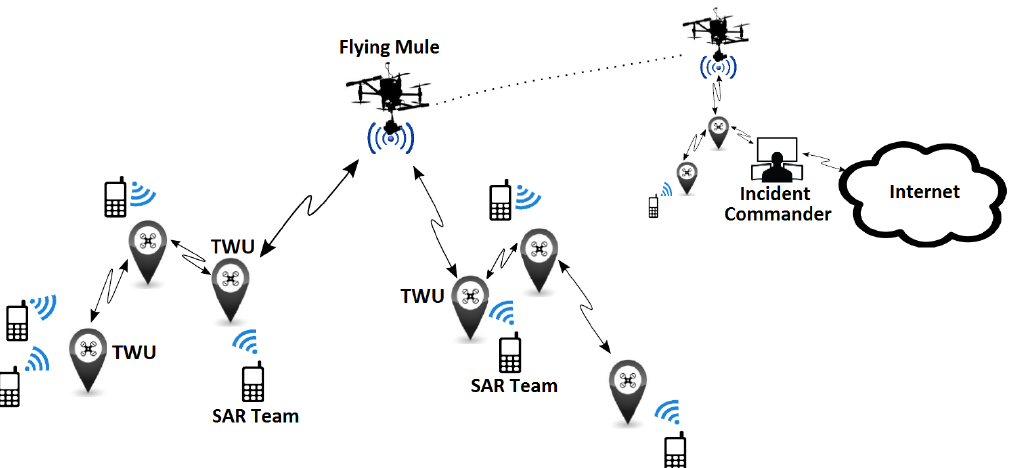
Figure 1. Example of an FRTN that includes eight team-centered witness units (TWUs) and two flying mules. Members of search-and-rescue (SAR) teams are depicted by smartphones, the “location” symbols near these devices are the TWUs, and the helicopters represents the flying